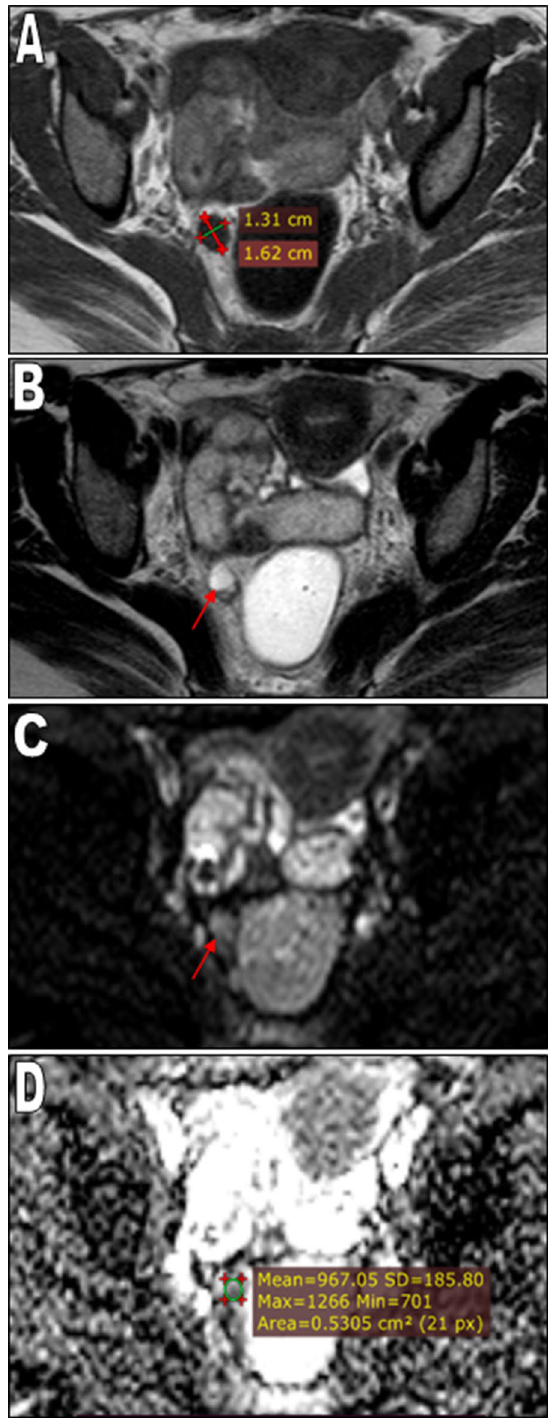
Fig. 2 MRI for a 58-year-old female patient with pathologically proven rectal adenocarcinoma presented clinically with tenesmus and bleeding per rectum. A Axial T1 WI and B Axial T2 WI showed enlarged right peri-rectal lymph node measuring 16 13 mm × at maximum axial dimensions, eliciting intermediate T1 and heterogeneous high T2 signals, has an oval configuration with regular borders, morphologically it is considered to be suspicious lymph node. C DWI and D ADC map showed restricted diffusion, with the predominant bright areas on DWI corresponding to low signal areas on the ADC map ADC mean 0.96 10 –3 mm 2 /s. Histopathological = × analysis confirmed metastatic nature of the examined lymph node